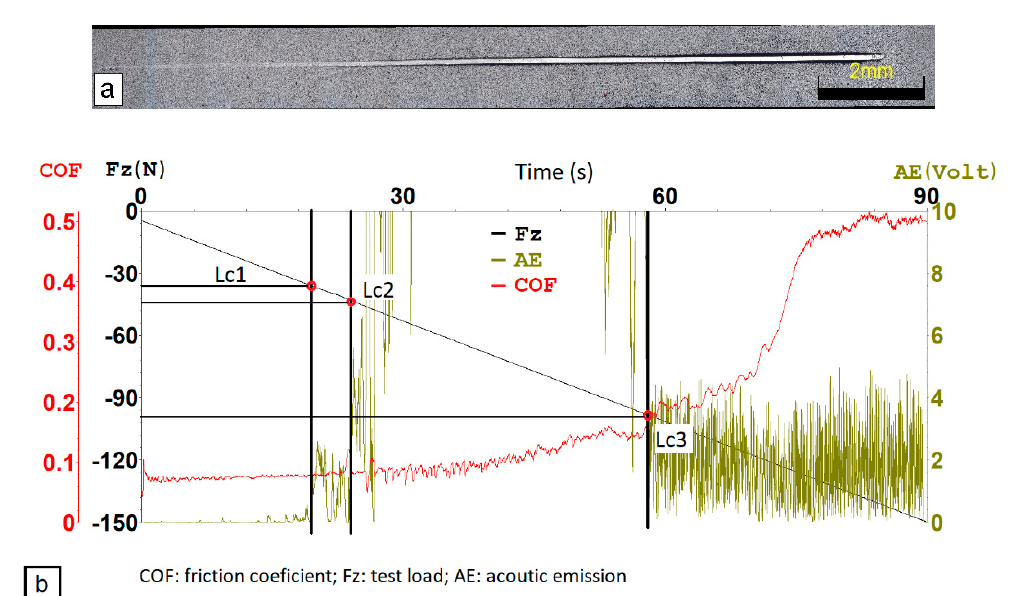
Figure 10. Critical loads of the coating AlCrBN on un-nitrided substrate of steel HS6-5-2 measured by scratch test: ( a ) optical micrographs of scratch scar; ( b ) relationship between the COF, AE, Fz and time test.